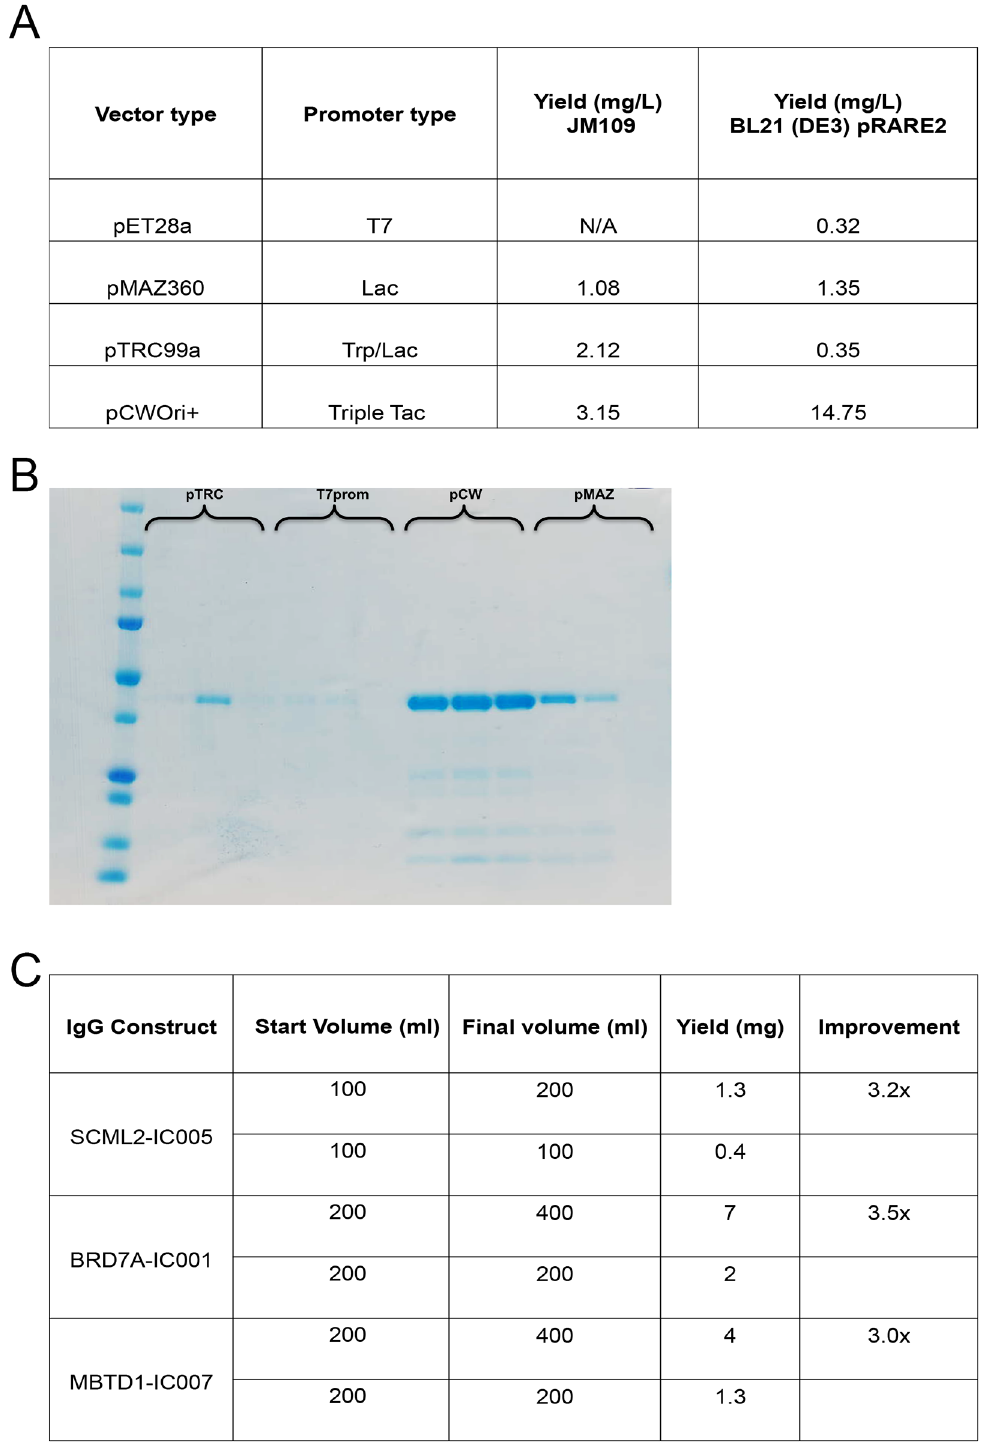
Fig 2. Fab and IgG production. (A) Comparison of purification yields between different expression vectors using an anti-MBP Fab as an example. The large-scale purification method on the ÄKTA Xpress including a heat denaturation step was used. (B) SDS-PAGE gel showing the anti-MBP Fab produced with various expression vectors and purified in triplicate. (C) IgG production yields with and without the dilution strategy.